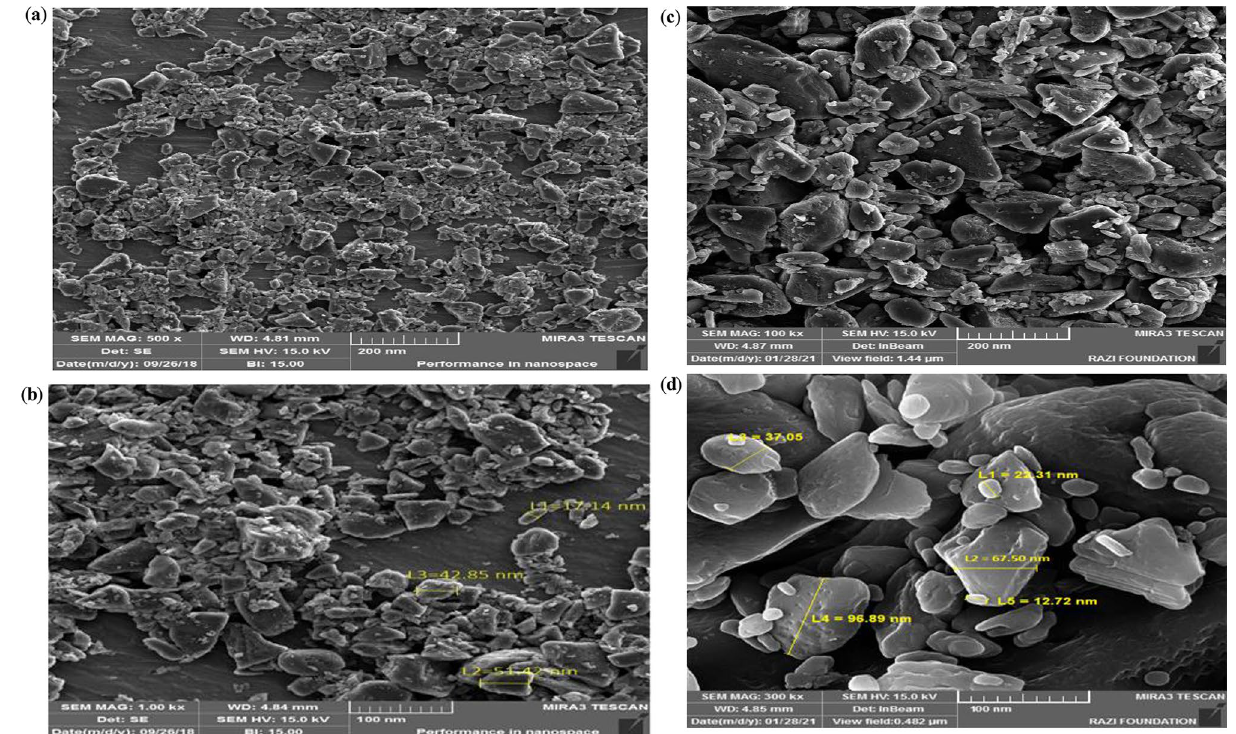
Figure 4. SEM images of the fresh nano-ordered Melamine@TMG ( 1 , a , b ) and the recycled Melamine@TMG catalyst after five consecutive runs in the model reaction ( c , d